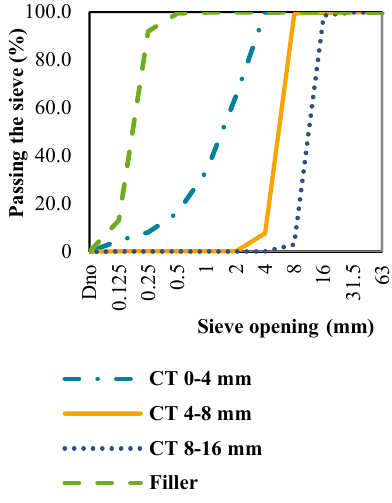
Figure 2. Grading curves of crushed roof tiles.